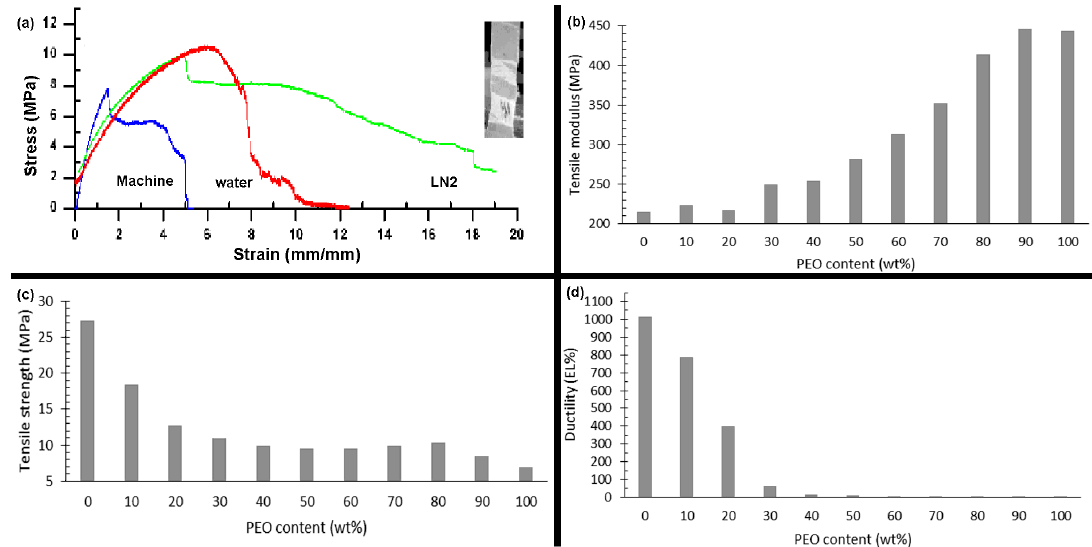
Figure 1. Effect of poly(ethylene oxide) (PEO) content on tensile properties of compression molded poly( ε -caprolactone) (PCL) films: ( a ) stress-strain curves for PCL / PEO 50:50 for di ff erent cooling techniques, ( b ) tensile modulus (MPa), ( c ) tensile strength (MPa), and ( d ) ductility (EL%).